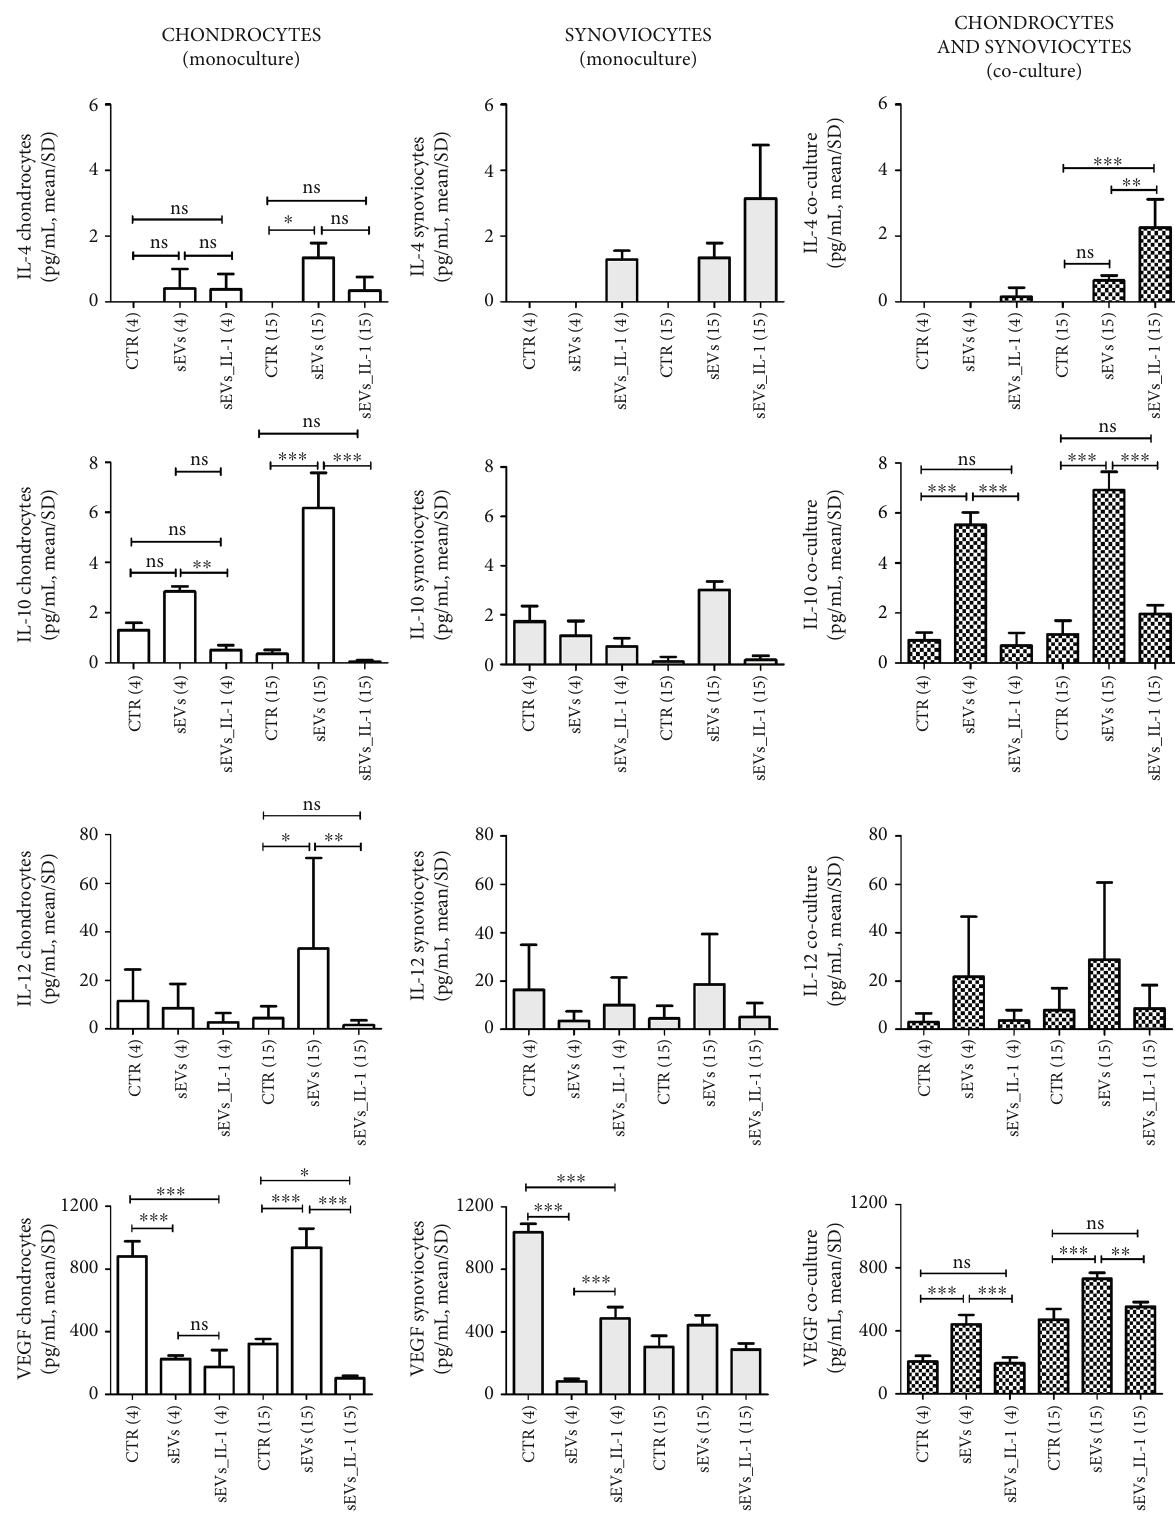
Figure 7: sEVs_IL-1 e ff ects on the protein release of another subset of cytokines with reported antiin fl ammatory e ff ects (IL-4, IL-10, IL-12, and VEGF) as assessed by Bioplex. Flanked results obtained from chondrocytes (white pattern), synoviocytes (grey pattern), and co-culture of these cells (pixelated pattern). For each cell type, results are shown obtained in CTR, sEVs, or sEVs_IL-1 conditions. Each graph reports data collected from 3 independent sEVs samples and expressed as means ± SD . Data were compared by ANOVA, followed by Tukey ’ s post hoc test, with ∗ p < 0 : 05 , ∗∗ p < 0 : 01 , and ∗∗∗ p < 0 : 001